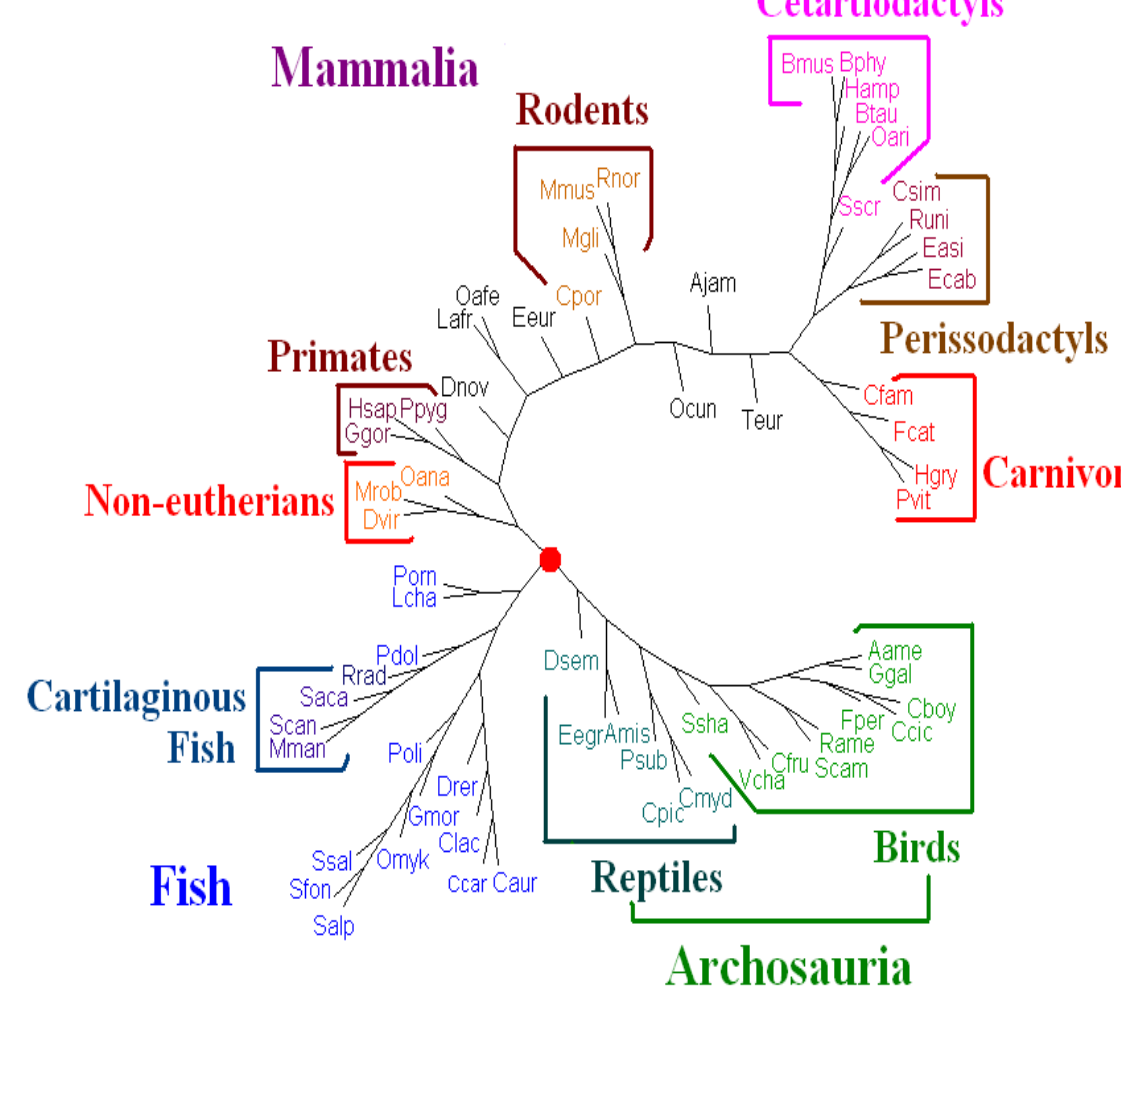
Figure 4. The NJ tree of mitochondrial genomes based on the whole DNA sequences using the dynamical language approach with chord distance in the case K = 11. In this tree the birds and reptiles group together as